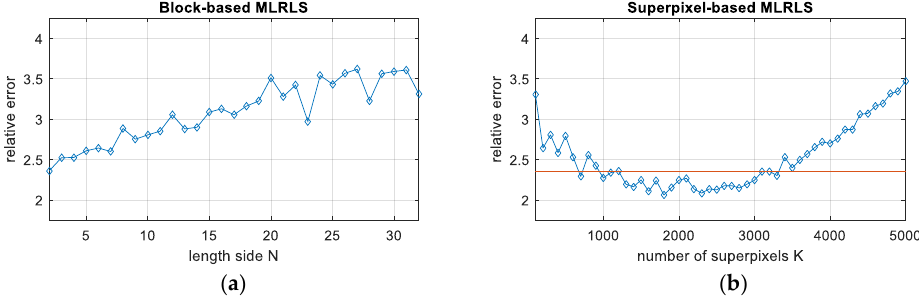
Figure 6. The relative errors of the overall concerned: ( a ) the block-based MLRLS and ( b ) the